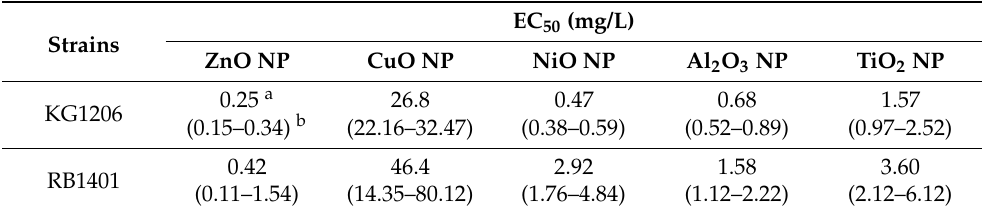
Table 1. Summary of the effects of NPs on the bioluminescence activity of two differently recombi- nated strains.